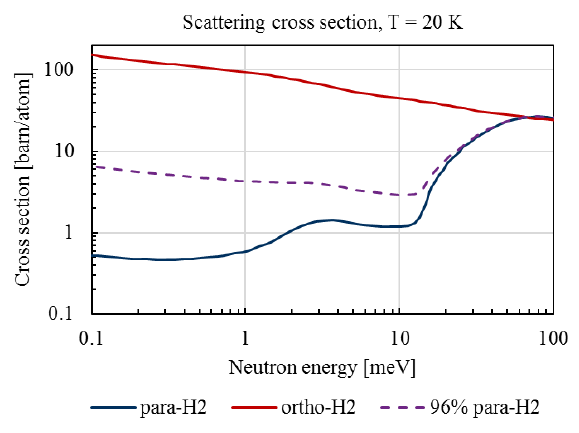
Figure 1. Scattering cross section of para-H 2 , ortho-H 2 [3] and a mixture containing 96% para-H 2 as a function of neutron energy. The data for the creation of this diagram has been extracted from plots presented in